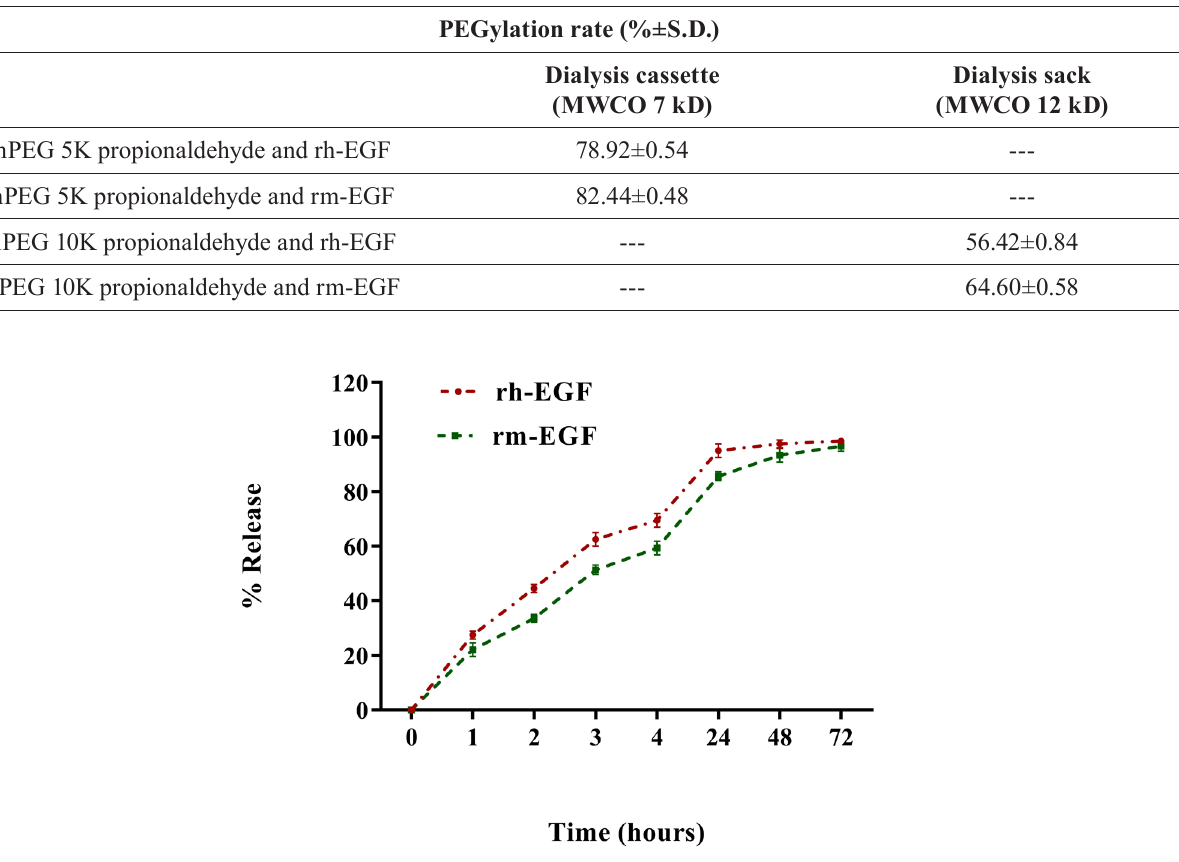
FIGURE 3 - In vitro release profile of rh-EGF(A1) and rm-EGF(F2) from chitosan-PVA hydrogel at pH 5.8 phosphate buffer saline at room temperature (n=3). rh-EGF: Recombinant human epidermal growth factor. rm-EGF: Recombinant mouse epidermal growth